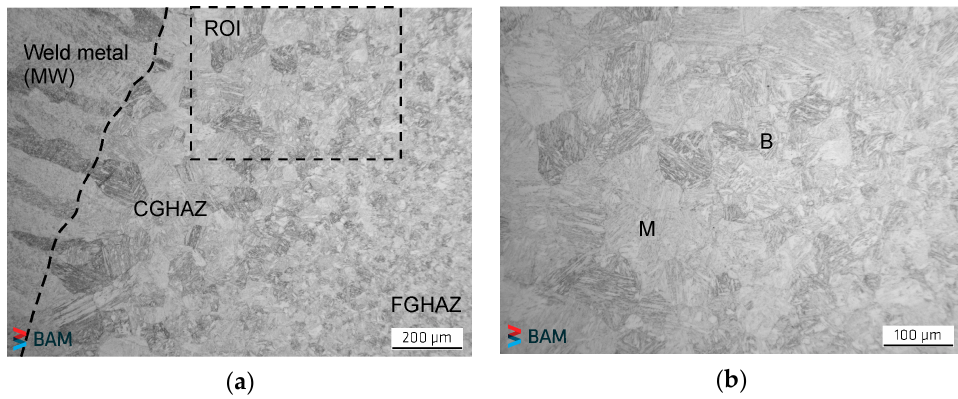
Figure 6. Exemplary microstructure in TEKKEN sample (metal cored wire, α = 30°): ( a ) image by light optical microscopy with region of interest (ROI); ( b ) ROI in detail with microstructure in the CGHAZ—B and M are bainite and martensite.